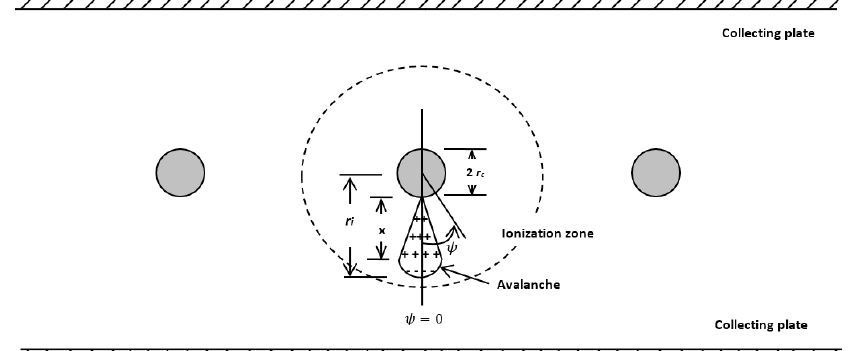
Figure 4. Development of an avalanche.